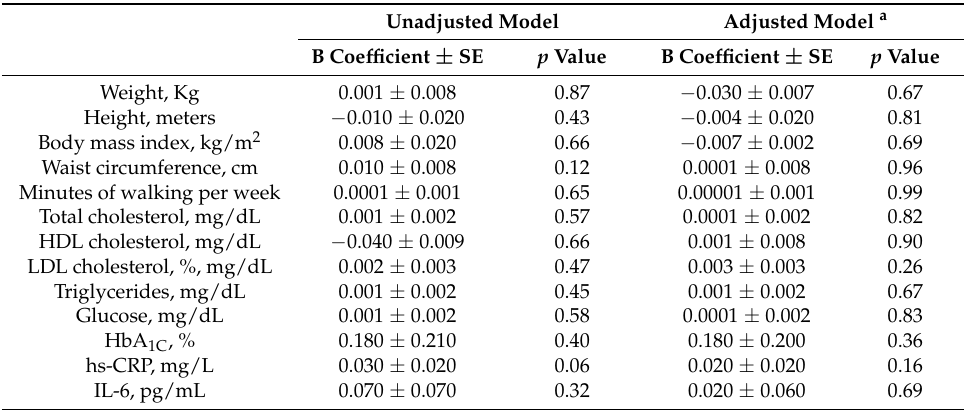
Table 3. Linear regressions of ln T/S ratio by anthropometrics measures, minutes of walking, blood metabolic and inflammatory biomarkers ( n =